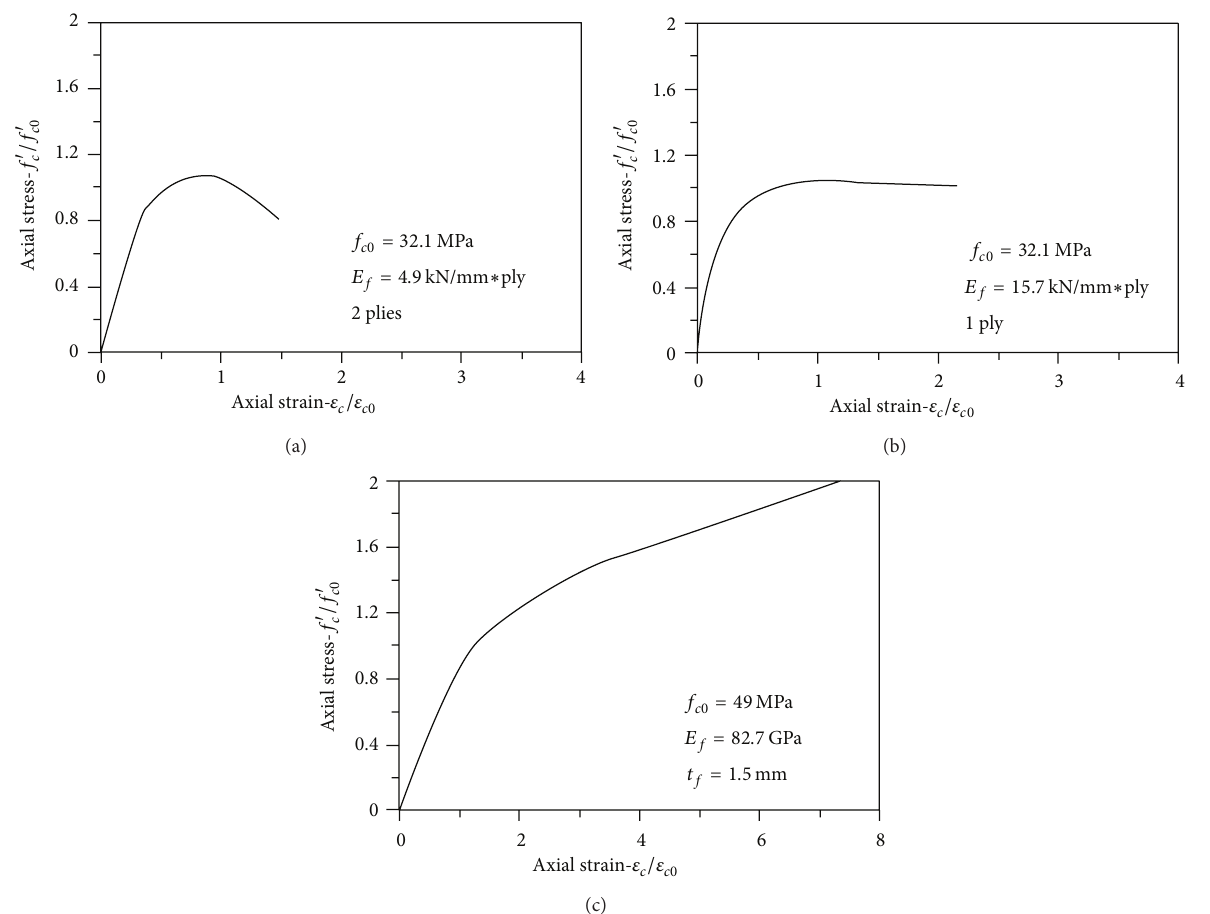
Figure 1: Experimental stress-strain relationships with different confinement levels: (a) Harries and Kharel [8]; (b) Harries and Kharel [8]; (c) Shahawy et al.